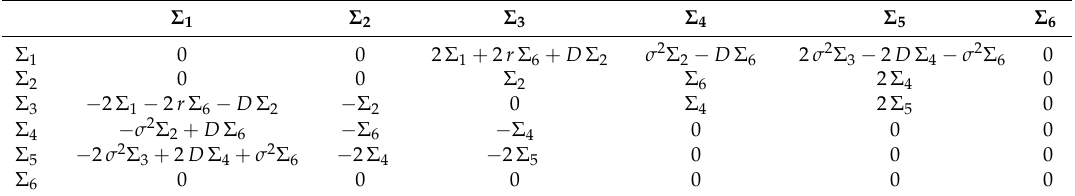
Table 1. Commutator table for the basis operators Σ i of the Black–Scholes equation.